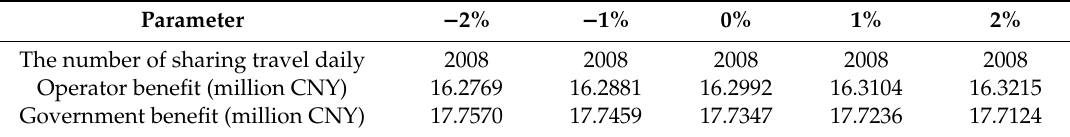
Table 4. Interests of all participants after adjustment of subsidy